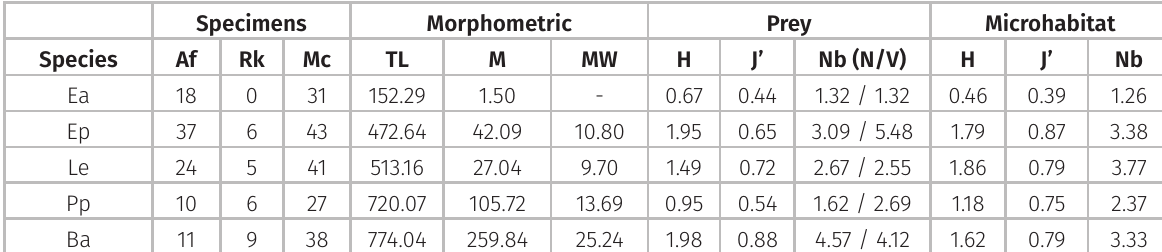
Table I. Field-collected (alive in field, Af; road-killed, Rk) and museum collection (Mc) specimens, and their morphological measurements (mean total length in mm, TL; mean mass in g, M; mean mouth width in mm, MW). The table shows the values of diversity (H), equitability index (J’), and niche breadth (Nb) for microhabitat use, prey number (N) and prey volume (V) categories. See text for details of calculations. Ea = Epictia australis , Ep = Erythrolamprus poecilogyrus, Le = Lygophis elegantissimus, Pp = Philodryas patagoniensis, Ba = Bothrops